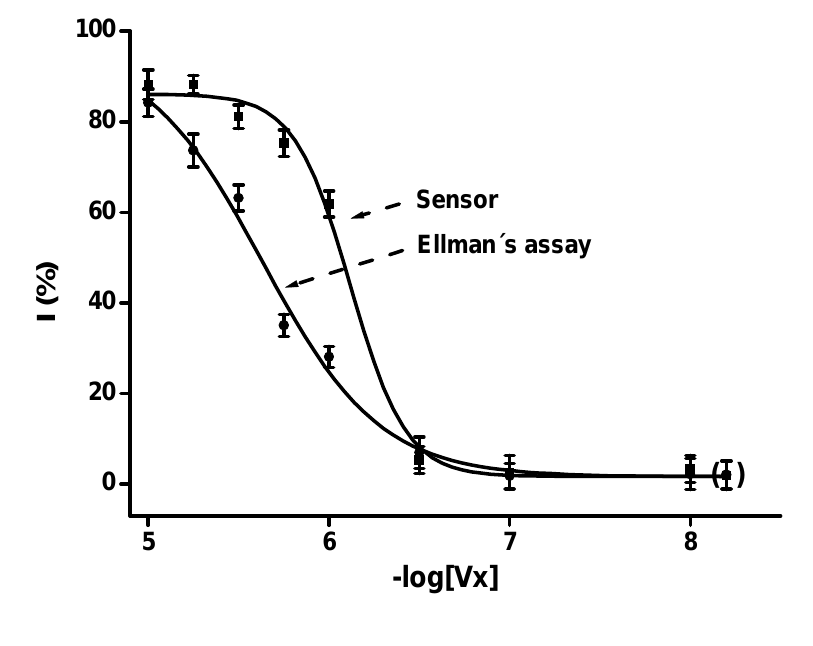
Figure 2. Presentation of calibration curves (percent of inhibition vs. VX concentration) for Ellman´s method and the electrochemical sensor. Concentration of VX in blood is expressed as the negative logarithm of molar concentration. Error bars indicate standard deviations (n=4) and points in brackets blank (unspiked